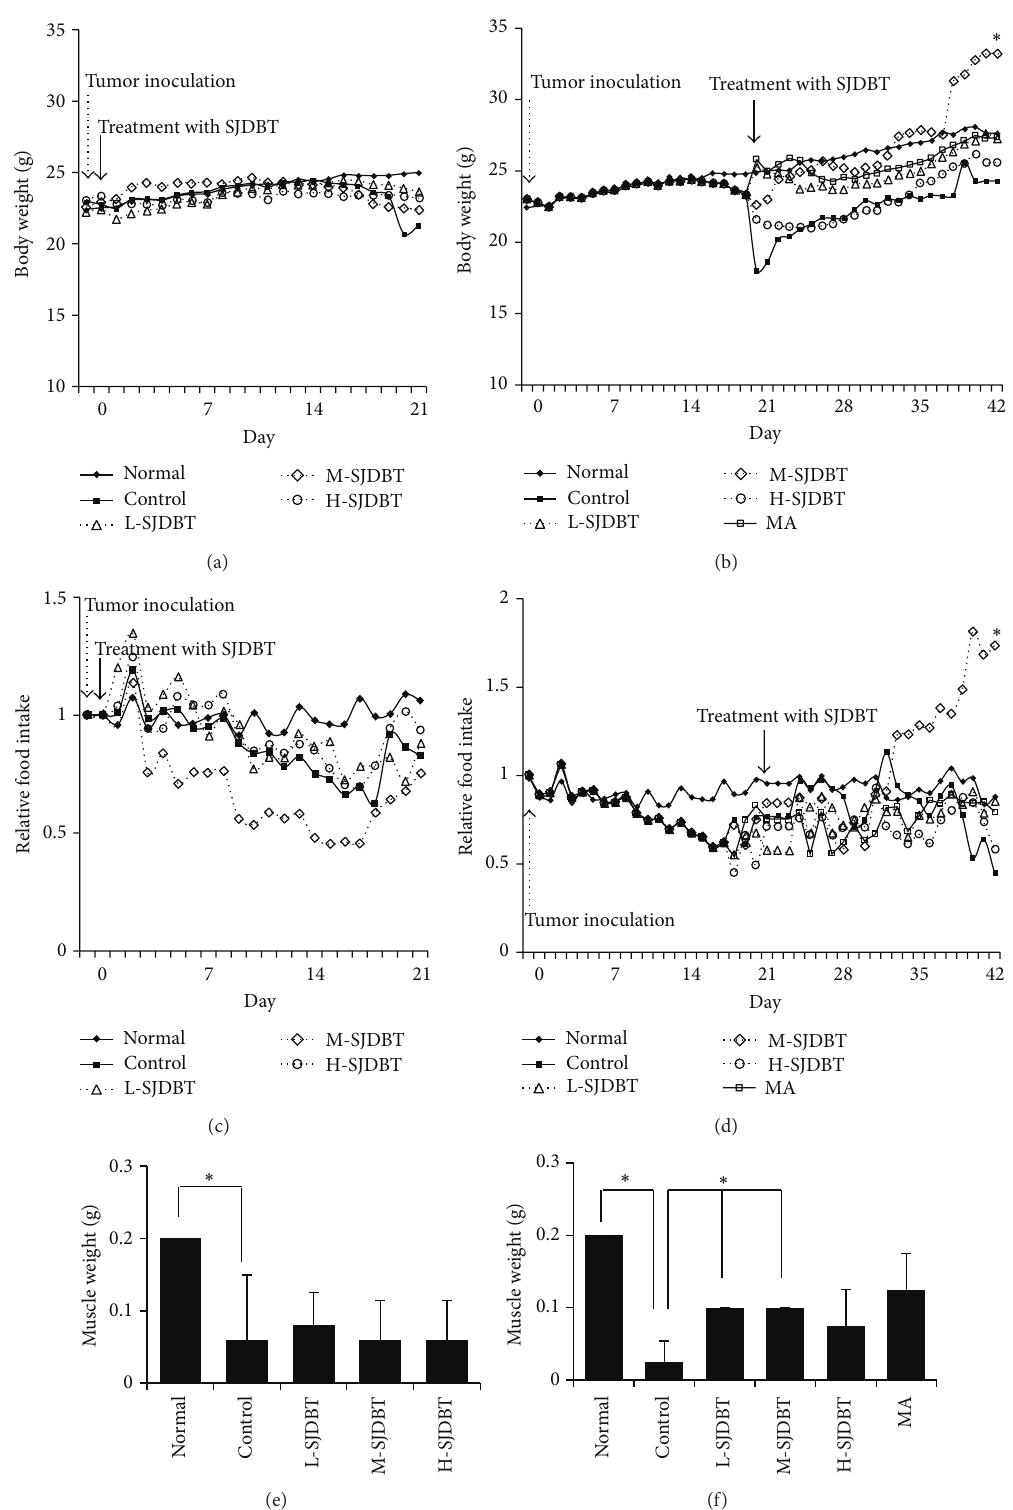
Figure 2: Effect of SJDBT on body weight and food intake in CT-26 tumor-bearing mice. ((a), (b)) Body weight of mice was measured every day at the same time. ((c), (d)) Food intake was measured every day at the same time. The measured quantity of food intake was divided by the number of total mice to determine each intake per animal a day. X : healthy normal mice ( 𝑛 = 5 ), ◼ : untreated control tumor-bearing mice ( 𝑛 = 5 ), △ : low concentration (6.784 mg/kg) of SJDBT-treated tumor-bearing mice ( 𝑛 = 5 ), ⬦ : middle concentration (67.84 mg/kg) of SJDBT-treated tumor-bearing mice ( 𝑛 = 5 ), I : high concentration (678.4 mg/kg) of SJDBT-treated tumor-bearing mice ( 𝑛 = 5 ), and ◻ : megestrol acetate-treated tumor-bearing mice ( 𝑛 = 5 ). ∗ 𝑃 < 0.05